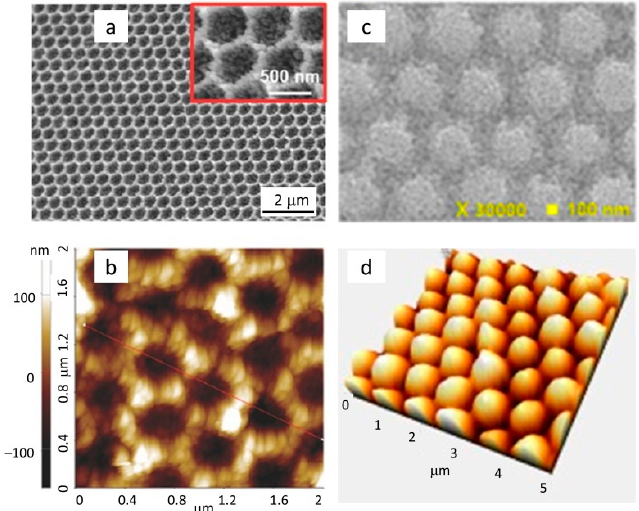
Figure 4. SEM ( top ) and AFM ( bottom ) images of two examples of different titania patterned electrodes in PSCs. ( a , b ) adapted with permission from [59], Copyright 2016, Wiley and Sons; ( c , d ) adapted with permission from Ref. [63], Copyright 2019, Elsevier B. V.